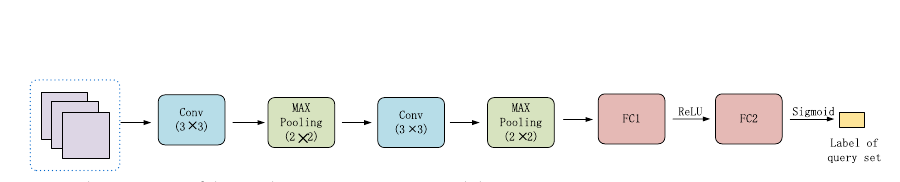
Fig. 5 The structure of the similarity measurement